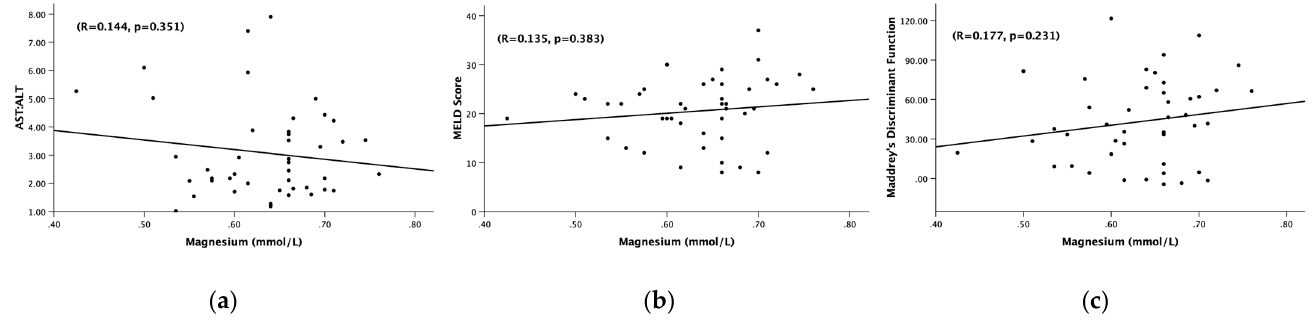
Figure 4. Association of the serum magnesium levels (mmol/L) and ( a ) AST:ALT ratio, ( b ) MELD score, ( c ) Maddrey’s discriminant function. ( a ) Association of the serum magnesium levels (mmol/L) and AST:ALT ratio among hepatitis patients with serum Mg < 0.78 mmol/L. ( b ) Association of the serum magnesium levels (mmol/L) and MELD score among all alcoholic hepatitis patients with serum Mg < 0.78 mmol/L. ( c ) Association of serum magnesium levels (mmol/L) and Maddrey’s discriminant function among all alcoholic hepatitis patients with serum Mg < 0.78 mmol/L. Statistical significance was set at p < 0.05. Correlational coefficient (R) is provided.